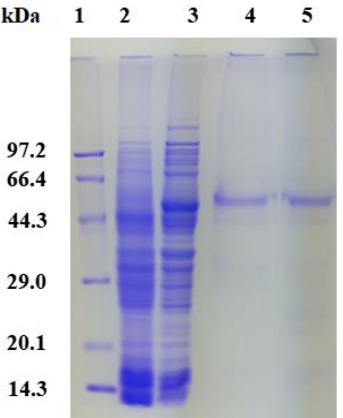
Figure 3. SDS-PAGE analysis of expression and purification of the recombinant PsGR (rPsGR). Lane 1, protein molecular weight marker; Lane 2, crude extract from the BL21 / pET-28a( + ); Lane 3, crude extract from the BL21 / pET-28a( + )-rPsGR; Lanes 4 and 5 purified rPsGR after Ni-NTA chromatography.